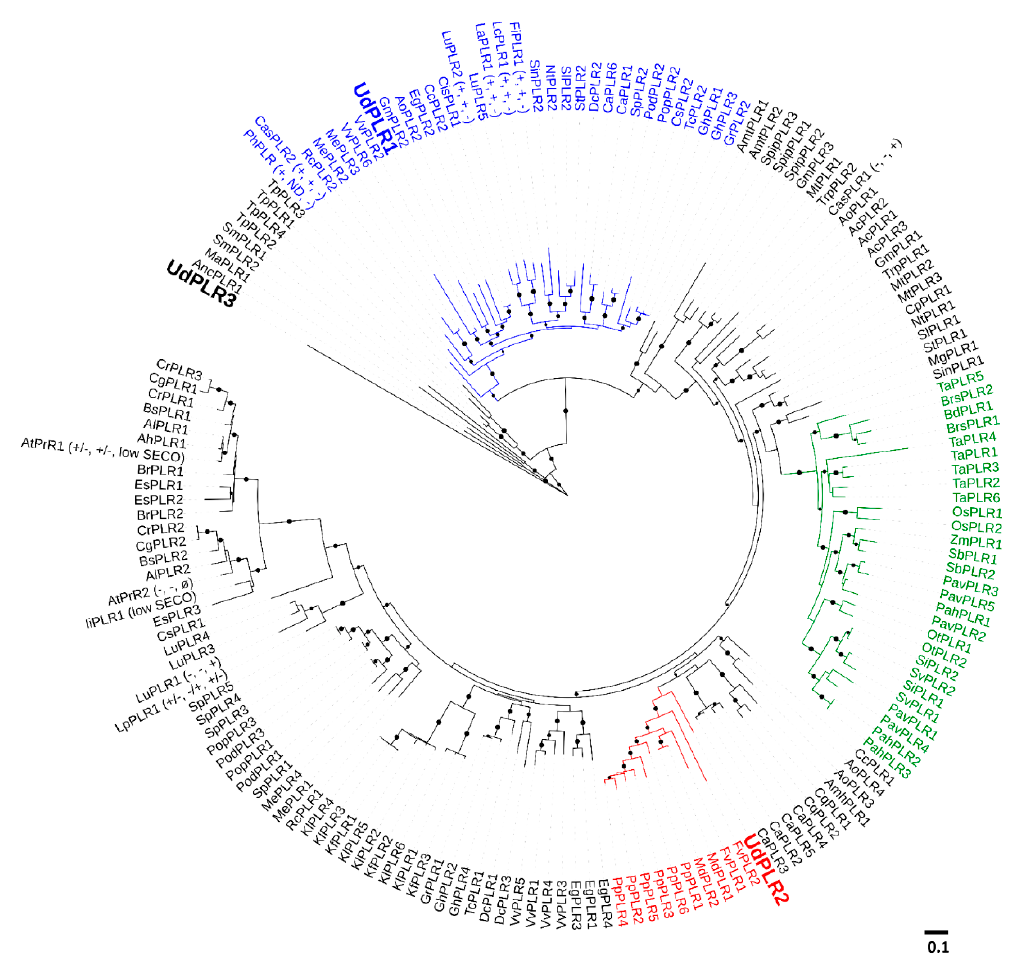
Figure 3. Phylogenetic tree of PLRs from different plant species. The tree was built by the maximum likelihood method with 1000 bootstraps replicates. Bootstrap values > 80% are displayed with black circles (the bigger the circle, the higher the value). Enantiospecificity of characterized PLRs are shown in brackets in the order of (PINO, LARI, SECO), + and − represent two different enantiomeric configurations. Ø refers to “not detected”. ND refers to “not determined”. The cluster of monocots are in green. The additional details of each protein see Table S2. The scale bar indicates 0.1 amino acid substitutions per